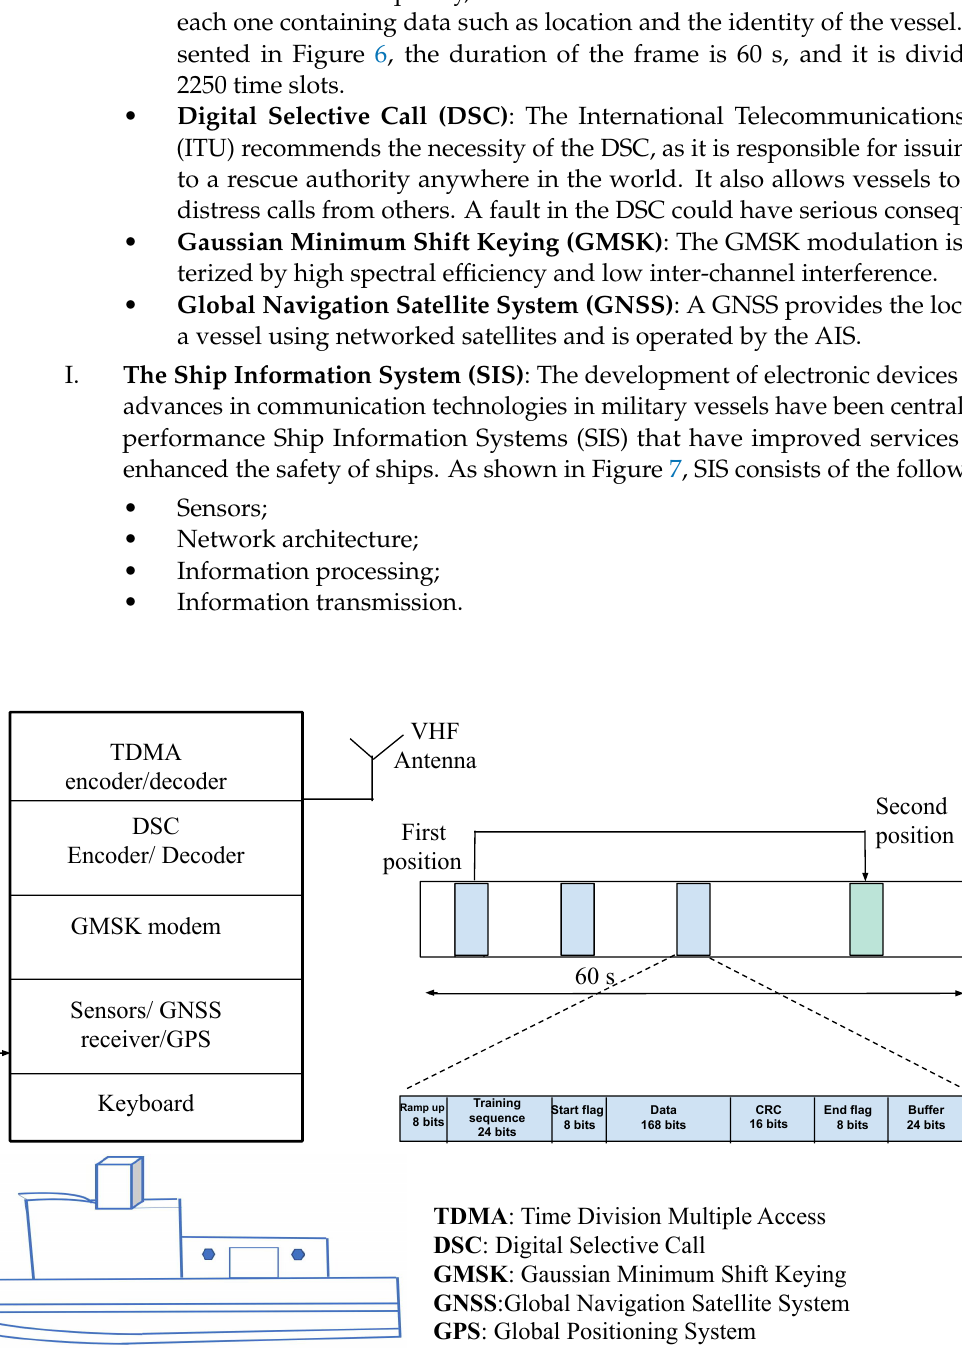
Figure 6. Simplified AIS class A